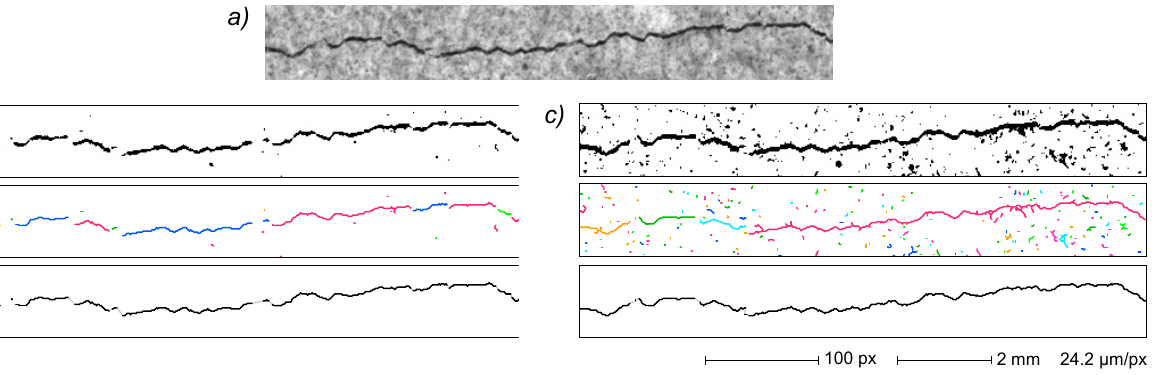
Figure 5. Effect of binarization threshold level. Original image ( a ) and binarization after thresholding at 55% ( b ) and 75% ( c ) of reference intensity level (the central value of the most significant peak in image histogram). For groups ( b , c ): binarization (top); primal EG (middle); final EG (bottom). In the final EG images, distal edges are depicted in gray.